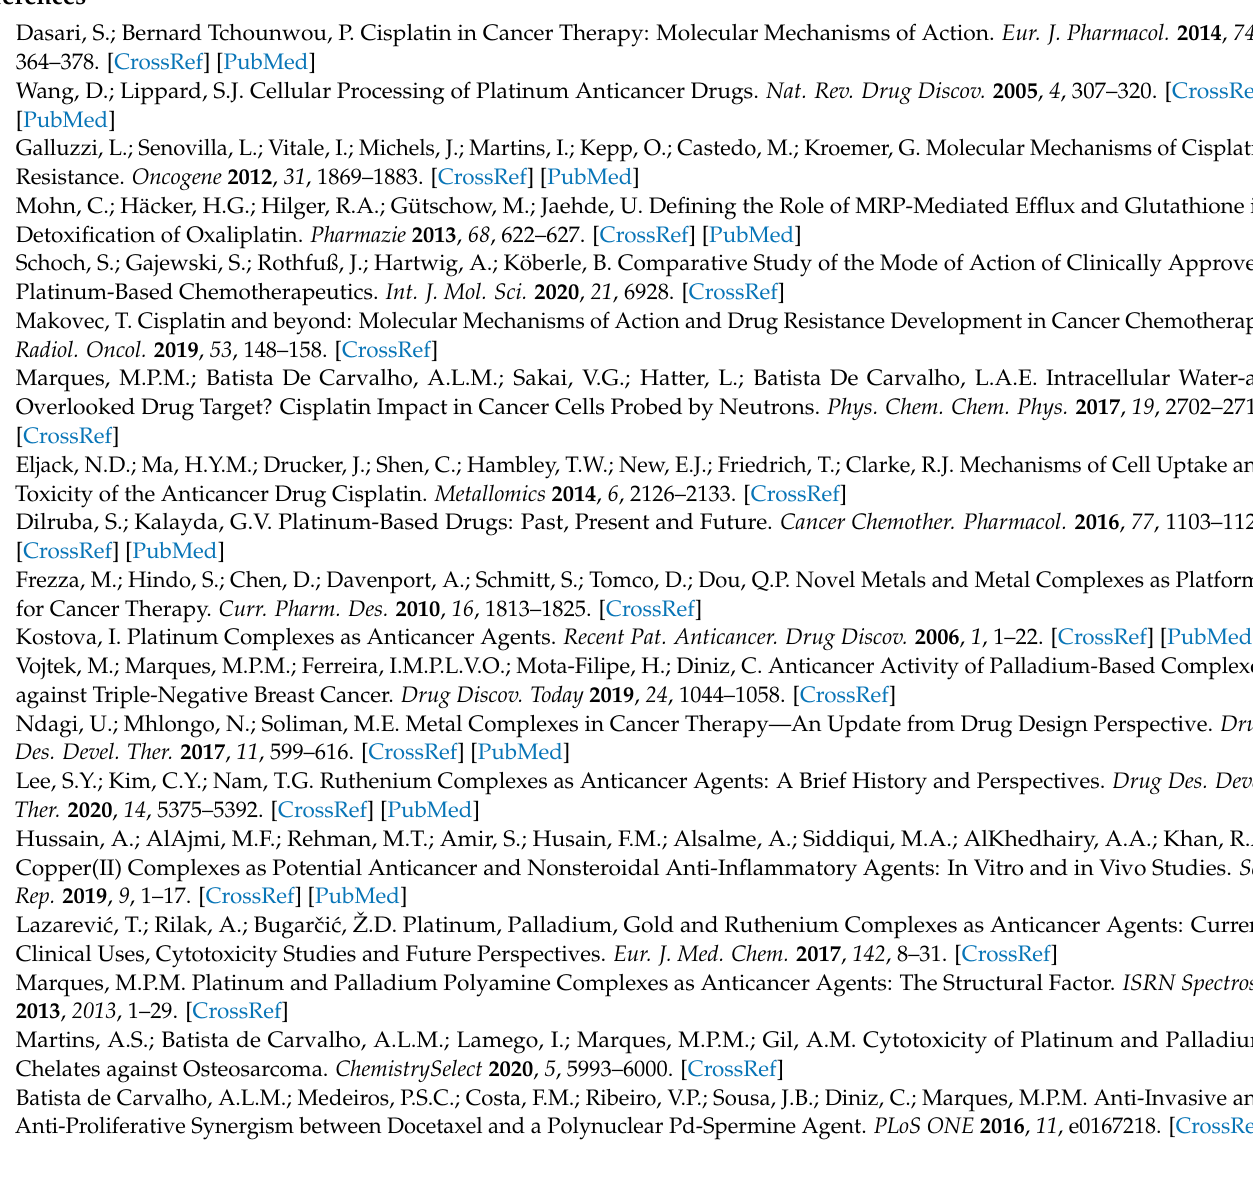
Figure A2. Metal dose-normalized kinetic profiles of Pd (from Pd 2 Spm, 3 mg/kg bw) and Pt (from cisplatin, 3.5 mg/kg bw) in tissues after single intraperitoneal bolus injection in Balb/c mice. Data are expressed as mean ± SEM ( n = 5 animals per time point). Units: h.ng/g per µg metal dose ( a ) Concentration–time plot of mean Pd levels (normalized to administered metal dose) in tissues. ( b ) Concentration–time plot of mean Pt levels (normalized to administered metal dose) in tissues.